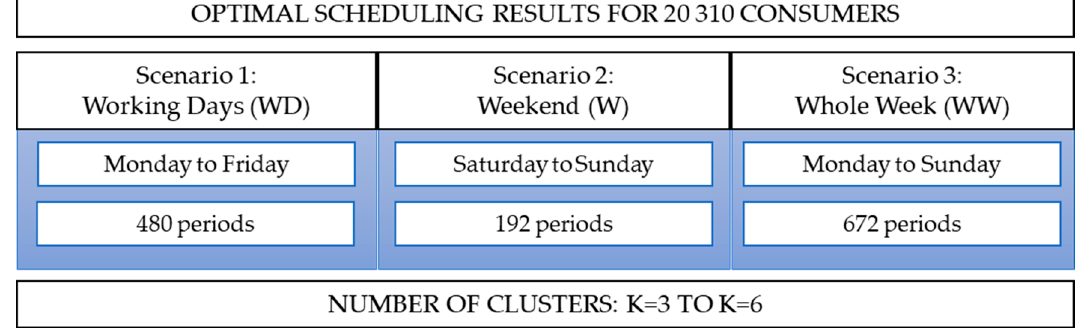
Figure 5. Elbow method results.